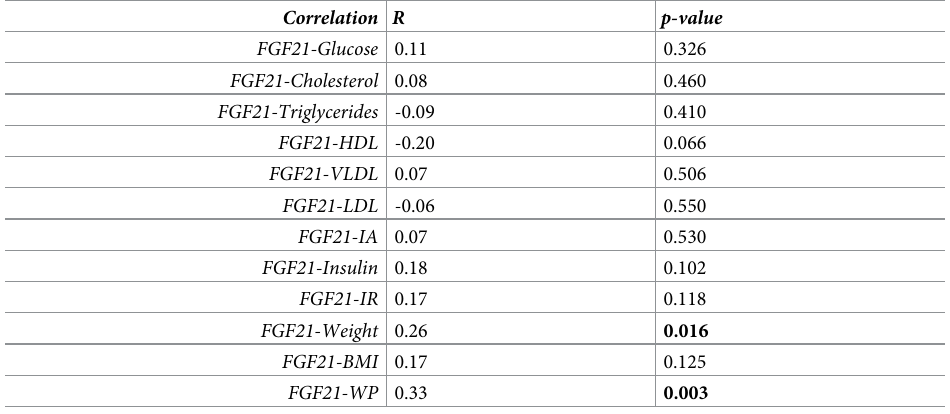
FGF21: fibroblast growth factor 21; HDL: high-density lipoprotein; LDL: low-density lipoprotein; VLDL: very